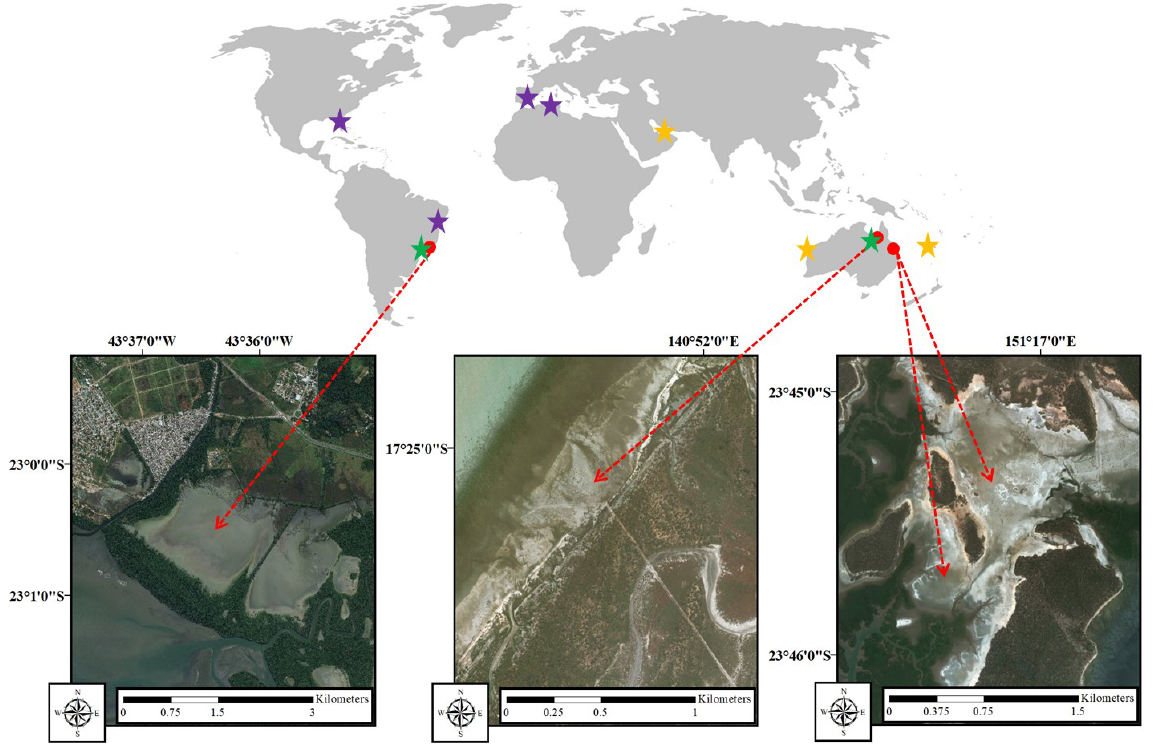
Figure 1. Study sites (red arrows): Guaratiba, Brazil (left); Karumba, Australia (centre); and Gladstone, Australia (right). Stars show the location of literature data summarised in Table 3. Purple stars are areas with only sediment carbon content data, green stars are areas with only gas flux data, and yellow stars are areas with both sediment carbon content and gas flux data from hypersaline tidal flat (HTF) studies (satellite images were taken from ©Google